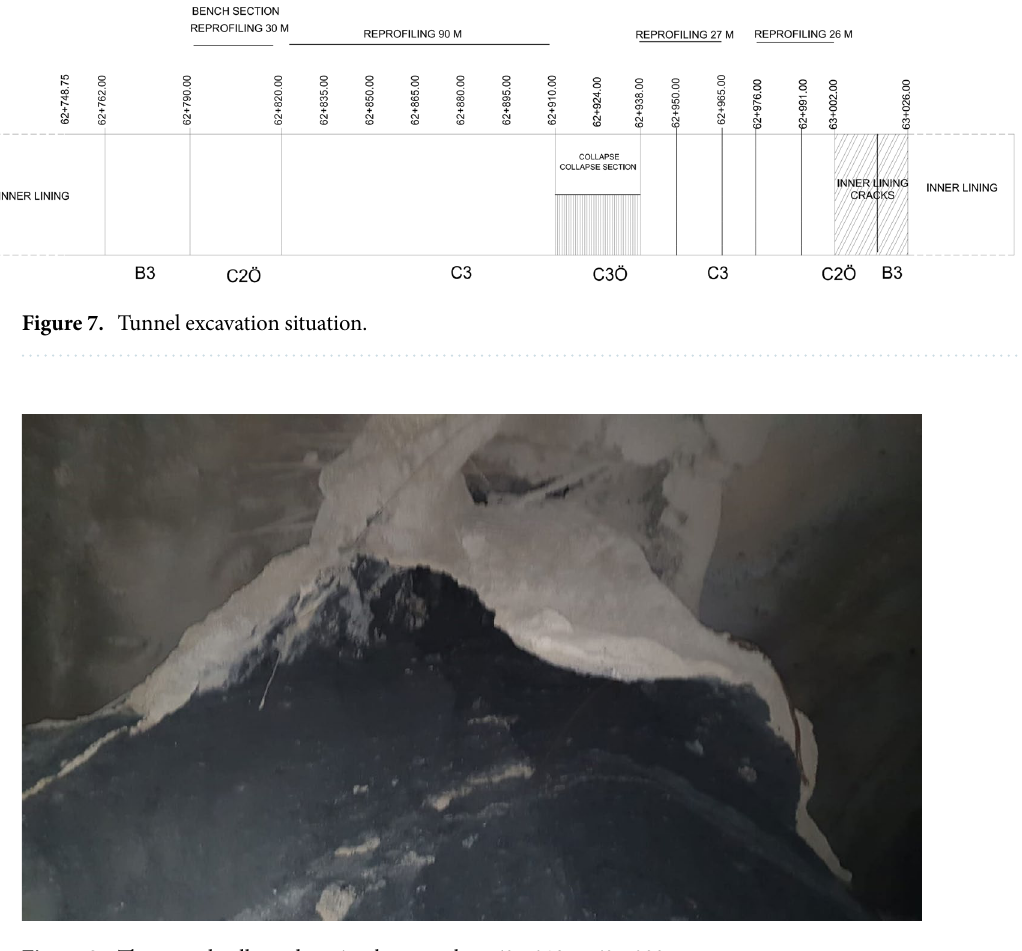
Figure 8. The tunnel collapsed section between km: 62 + 910 to 62 +